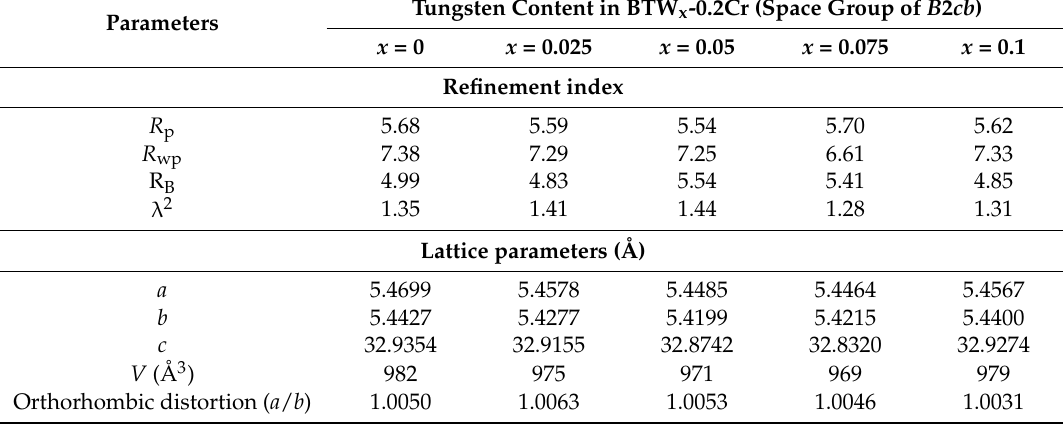
Table 3. Rietveld refinements for the crystal structure of BTW 0.05 -yCr at 295 K.